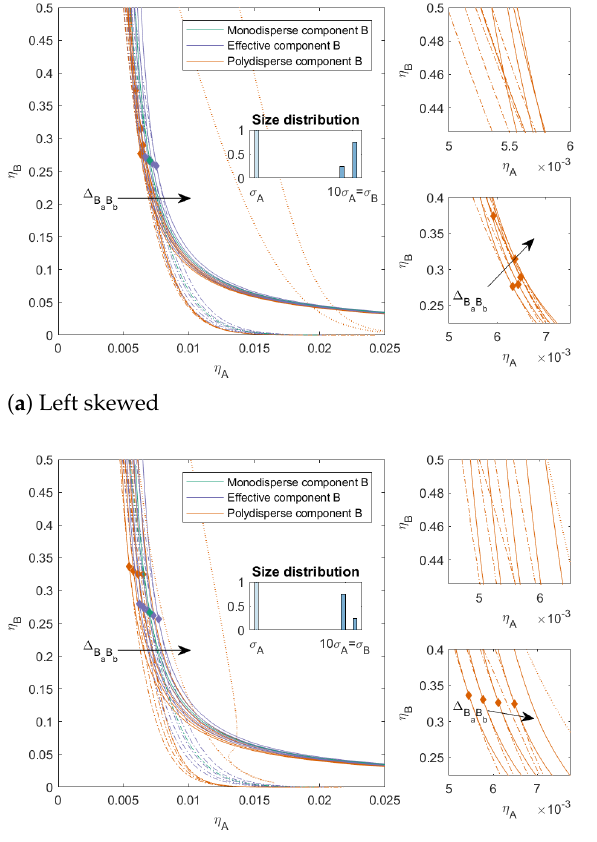
Figure 5. Phase diagram for binary (component A and B ) nonadditive hard sphere mixture with size ratio q = σ A / σ B = 1/10 plotted as a function of the partial packing fractions, η A and η B ; component A is monodisperse, component B is polydisperse ( PD = 6.93), . The symbols σ A and σ B refer to the diameters of the species A and B, respectively. The interaction between components A and B is additive, the interaction between the subcomponents B is nonadditive, the nonadditivity parameter ∆ − 0.1 to 0.1 with a step size of 0.05 (the arrow indicates increasing ∆ B a B b was varied from The spinodal (solid line) and binodal (dashed line) meet each other at the plait point (diamond), the three-phase boundary is indicated with a dotted line. The right-hand smaller figures represent zoomed in versions of the left larger figures.